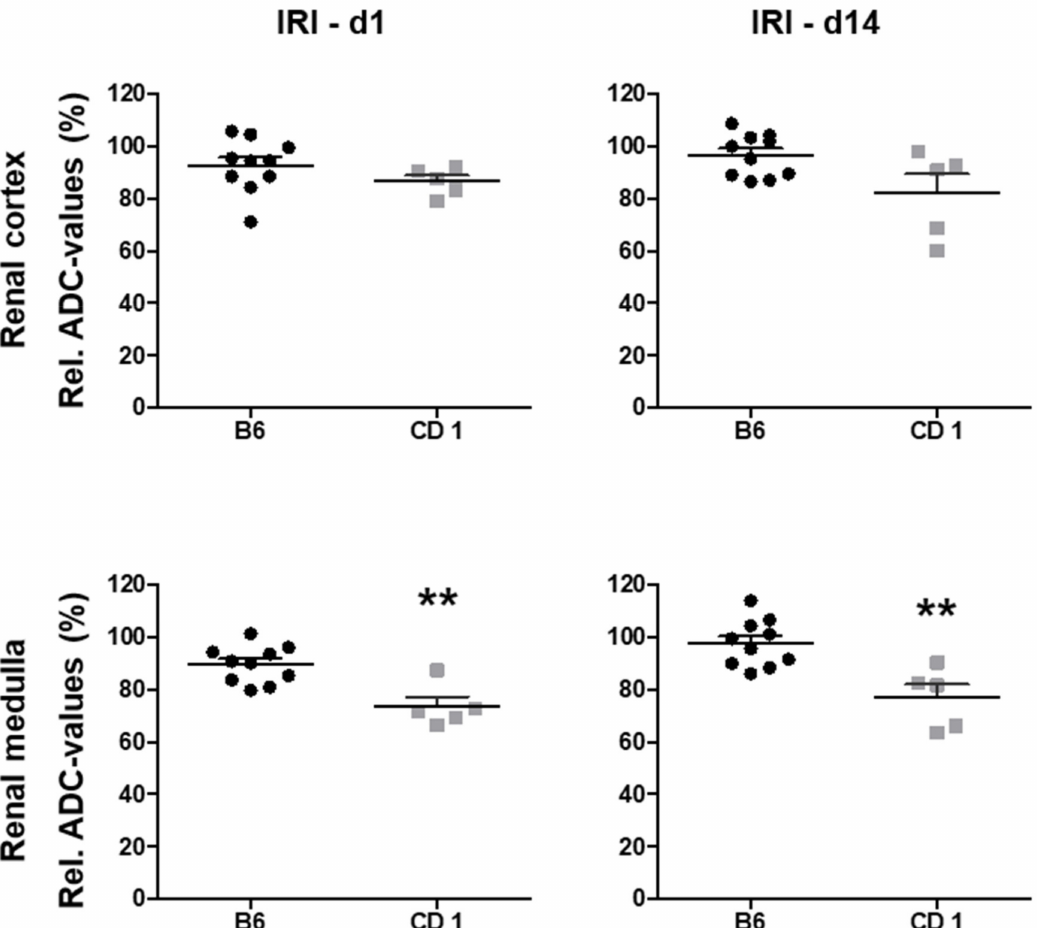
Figure 1. Diffusivity in the renal medulla was significantly more reduced in CD 1- mice compared to B6-mice on d1 and d14 after IRI. ADC-values were determined to quantify diffusivity in the renal cortex and renal medulla. Relative ADC-values were calculated as the percentage of ADC-values of the ischemic and the control kidney (the contralateral, non-ischemic kidney on d1 served as control). For the comparison of relative renal diffusion of the two mouse strains, un-paired t -tests (diffusion values of the renal cortex on d1, due gaussian distribution of data) and Wilcoxon rank sum tests (diffusion values of the renal cortex on d14, due to non-gaussian distribution of data) were performed. The presented dotplot diagrams show relative ADC-values of B6-mice ( n = 10, black dots) and CD 1-mice ( n = 5, grey squares) as well as mean and standard deviation. For both mouse strains, reduction of renal diffusivity can be detected after IRI. In the comparison of relative ADC-values of both mouse strains, relative ADC reduction is more pronounced in the renal medulla of CD 1-mice compared to B 6-mice on d1 and d14 after IRI. Diffusivity in the renal cortex was not significantly different between the two mouse strains. ADC = apparent diffusion coefficient, IRI = ischemia reperfusion injury, ** = p < 0.01.